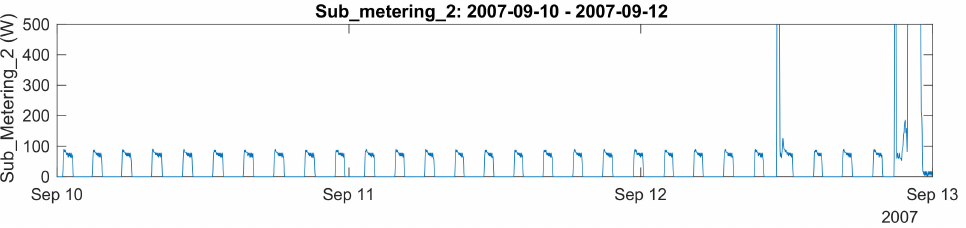
Figure 8. Sub_metering_2 power, during 3 days in September